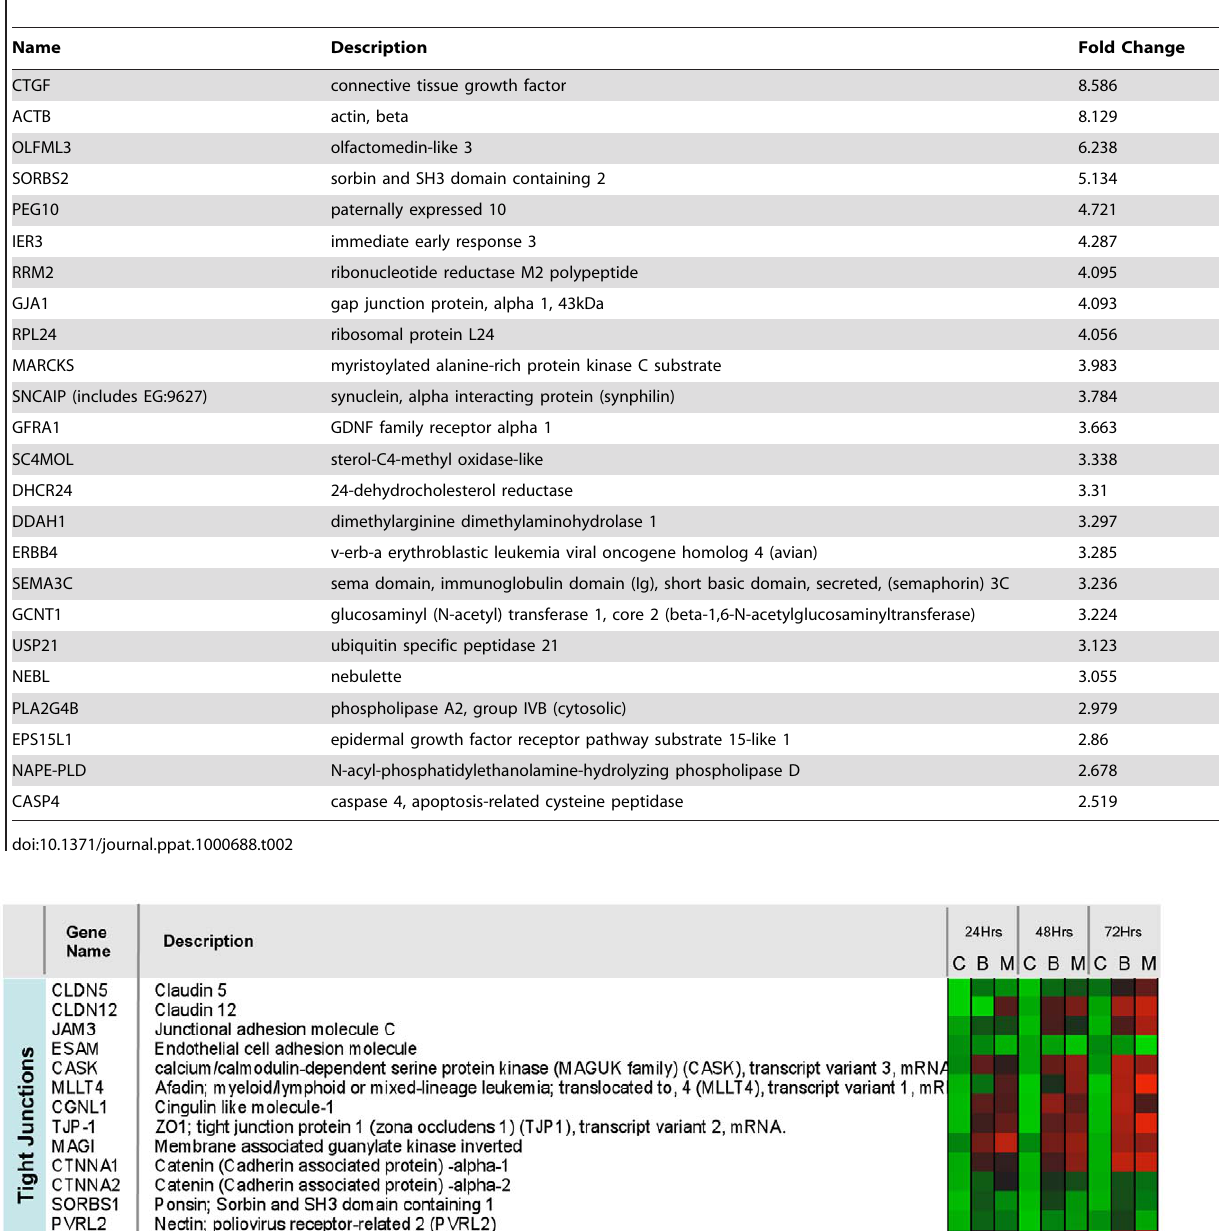
Table 2. List of MfAg induced 2-fold down-regulated genes.